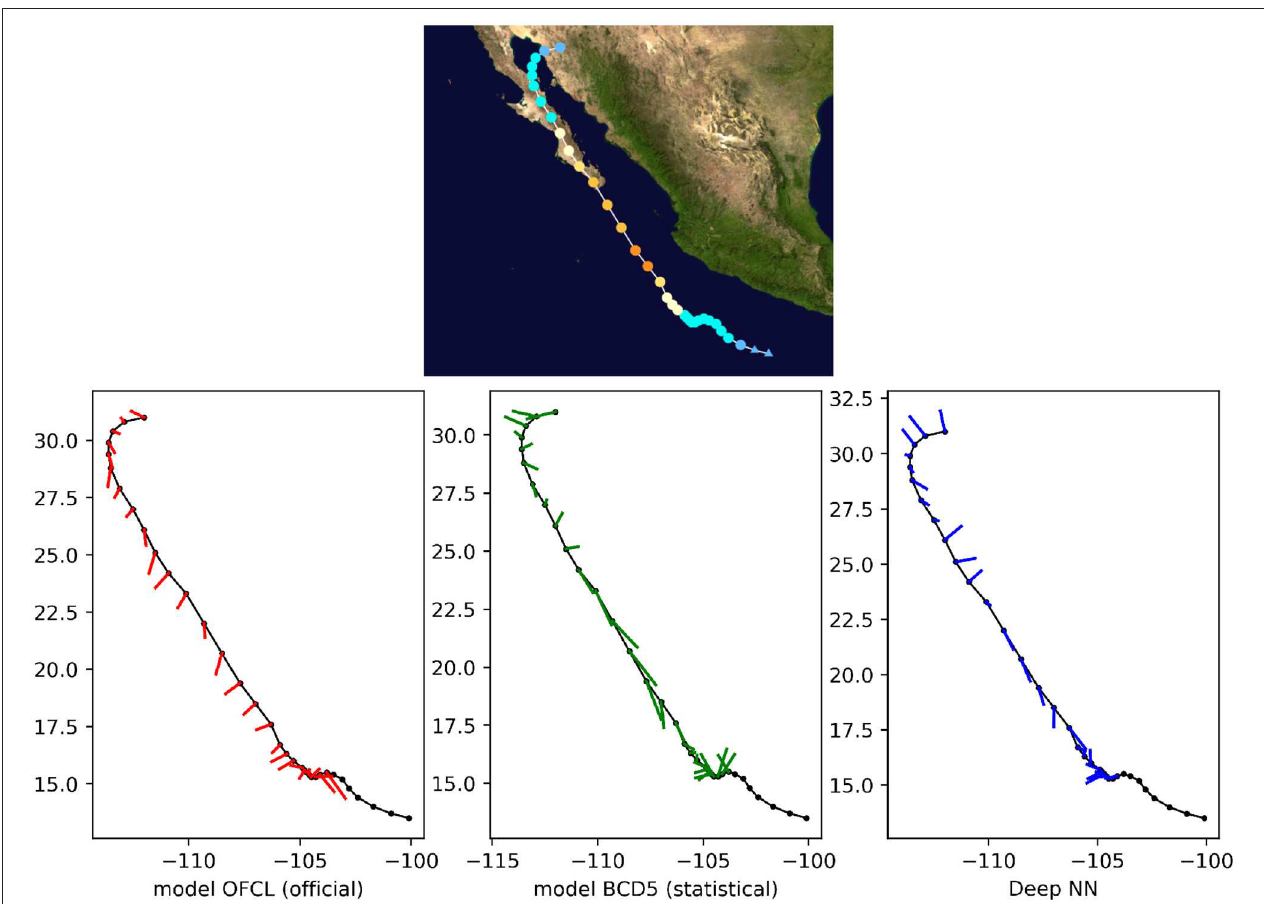
FIGURE 8 | 24-h forecast errors (4 time steps ahead) on Tropical Cyclone Odile in 2016. The bars connect each pair of predicted and ground truth location. The longer the length, the larger the error. At the beginning, the forecasts were not always available (a complete absence of an error bar should be interpreted as no forecast ).